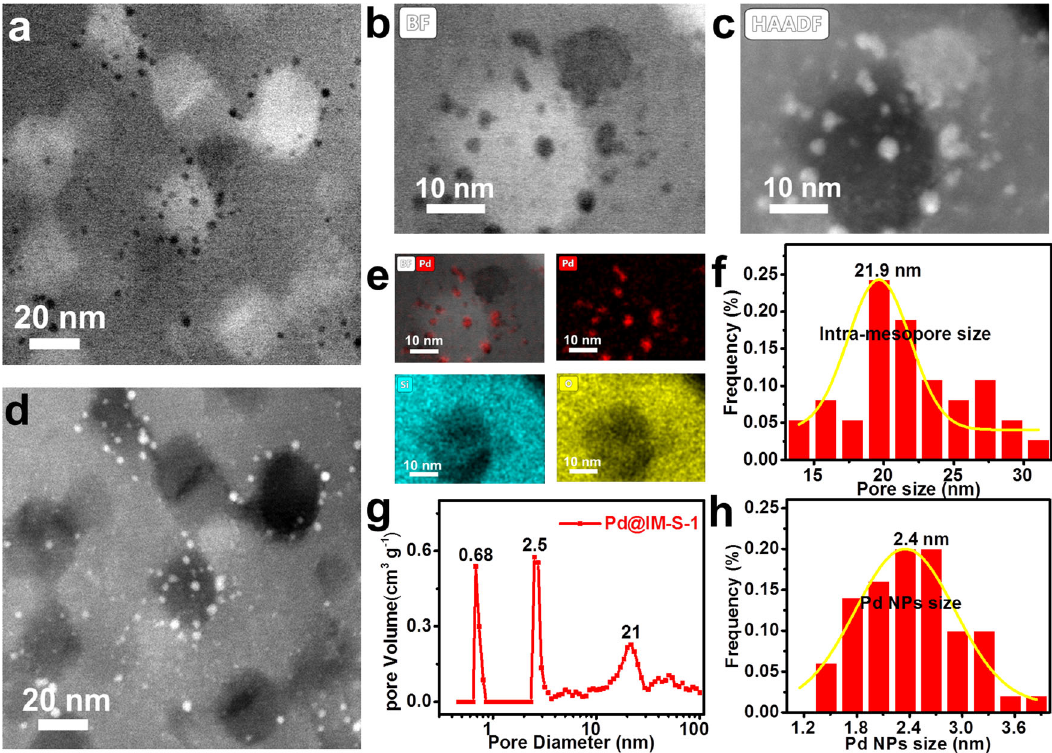
Fig. 2 Morphology and structural characterization of Pd@IM-S-1. a , b FIB-AC-BF-TEM, c , d FIB-AC-HAADF-TEM, e FIB-AC-EDS-mapping, f intra- mesopore size distribution, g pore size distribution curve, h Pd NPs size